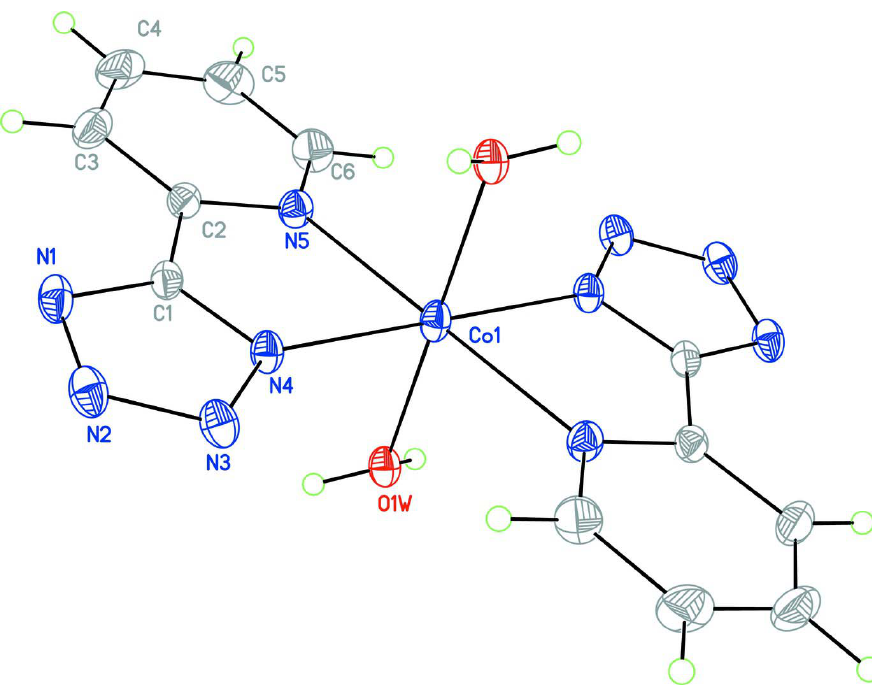
Figure 1 The molecular structure of (I), around Co II , displacement ellipsoids for the non-hydrogen atoms are drawn at the 50% probability level.